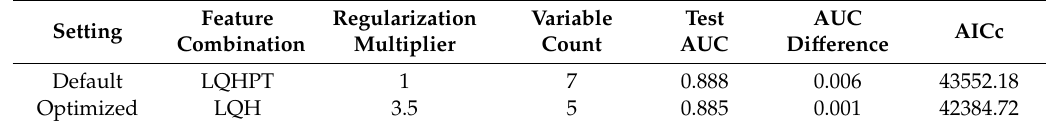
Table 2. Evaluation metrics of the default and optimal Maxent models.